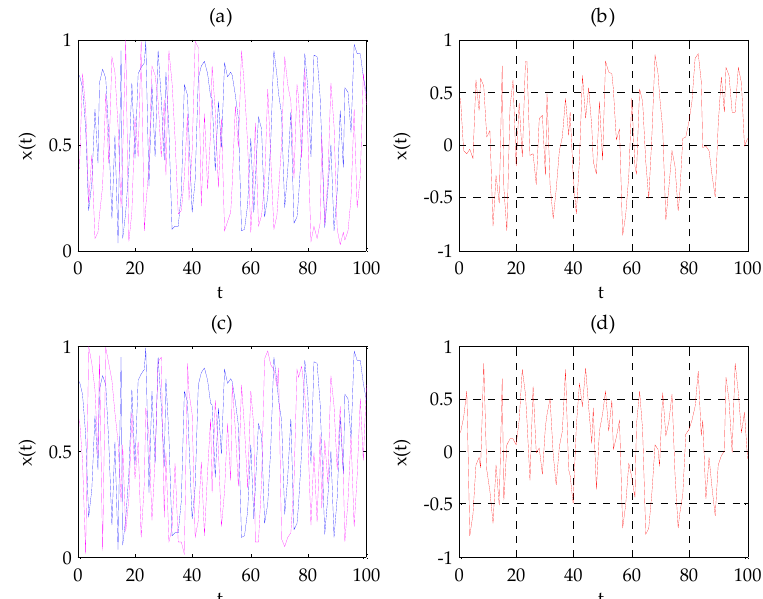
Figure 6. Exponential Lyapunov spectrum of the five-dimensional system (2).